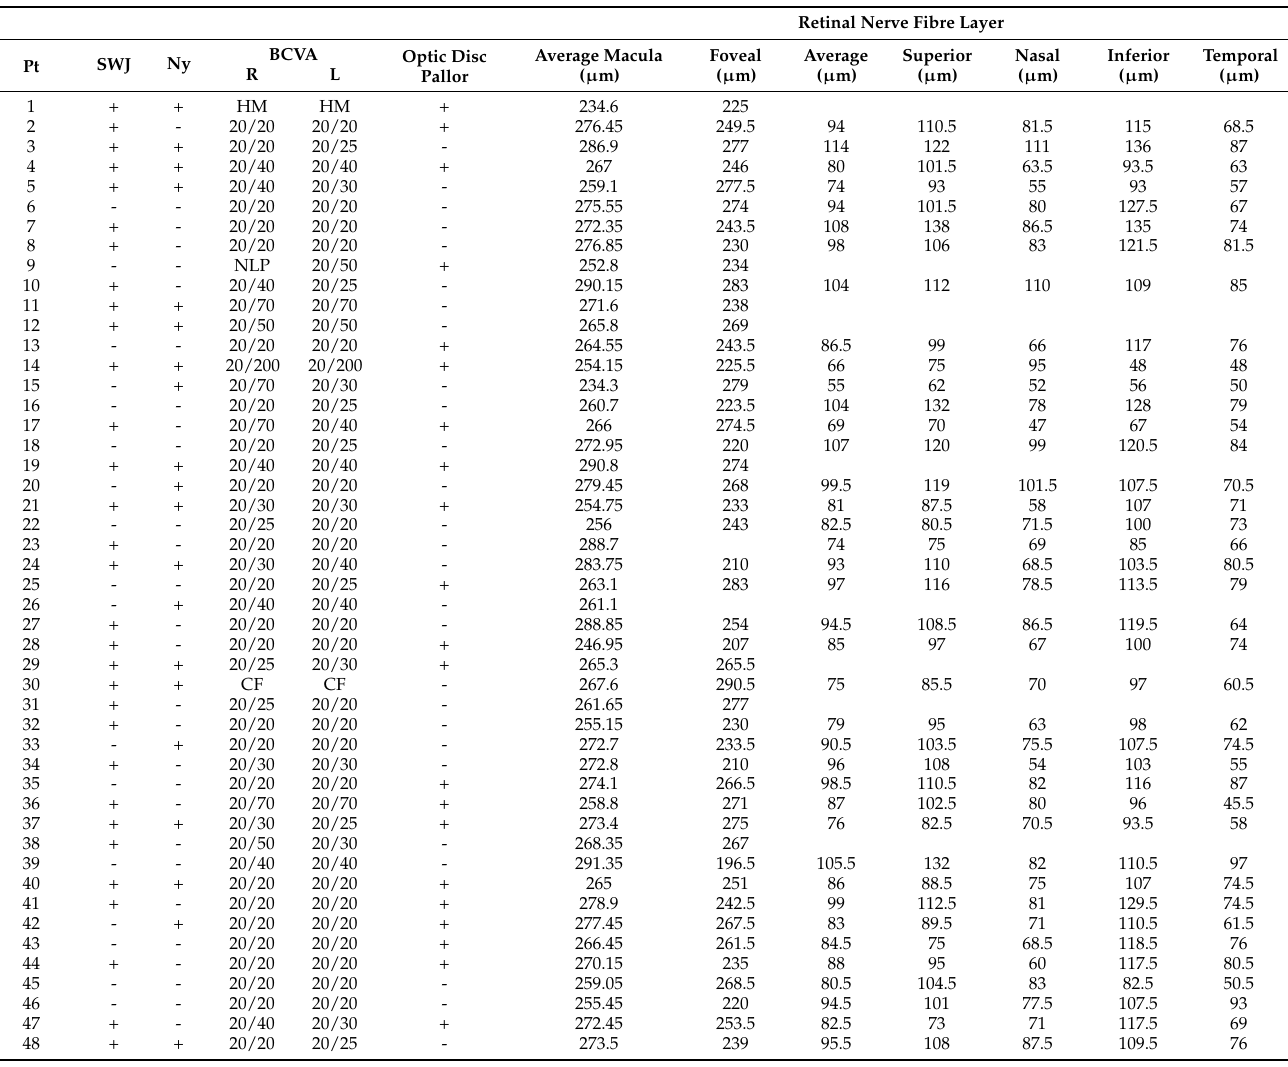
Table 2. Ophthalmological findings and RNFL results in patients with